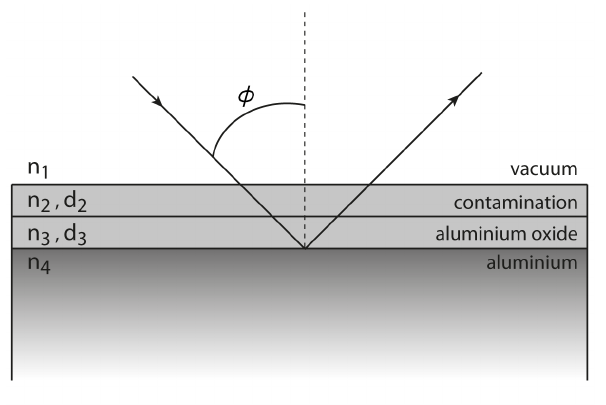
Figure 4. Layers and angle definitions used in the mirror model with thickness ( d i ) and complex refractive index ( n i ). Left: annota- tion for the general case; right: materials for SCIAMACHY appli-